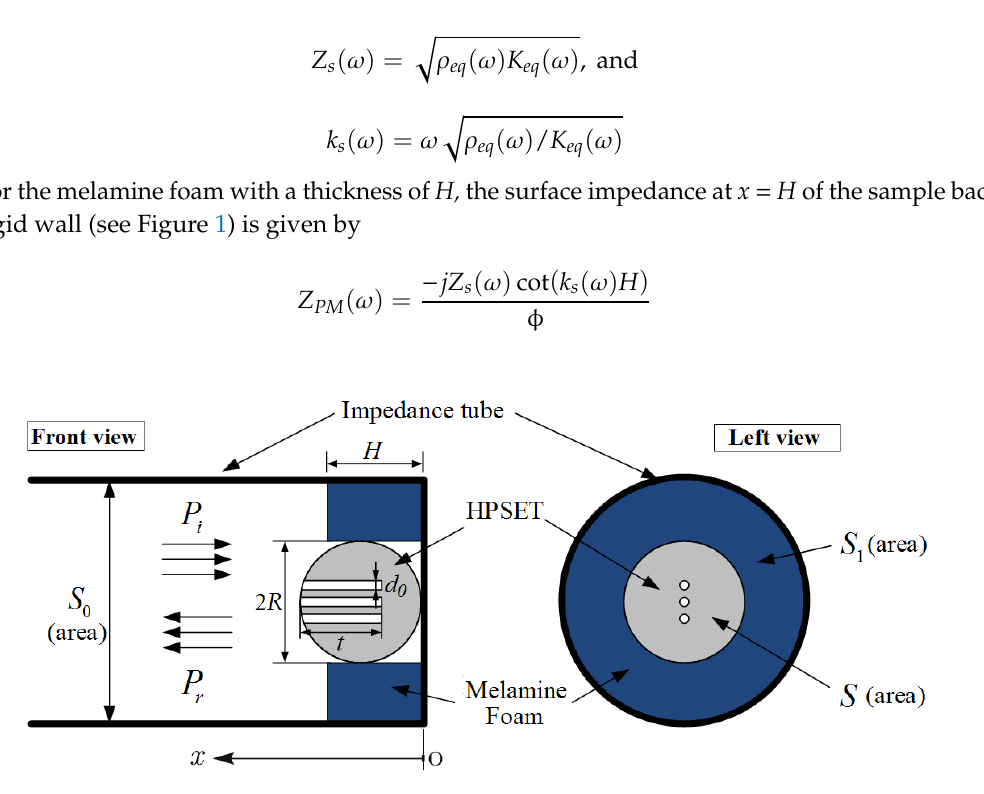
Figure 1. Illustration of HPSET and melamine foam installed at an impedance tube. The thickness of the foam is H , and the inner diameter of the HPSET is 2 R . The diameters and the maximum length of the extended tubes are d 0 and t . All extended tubes inlets are shaped to follow the sphere curvature. The cross-sectional areas of HPSET and impedance tube are S and S 0 . Table 1. Parameters of the melamine foam.